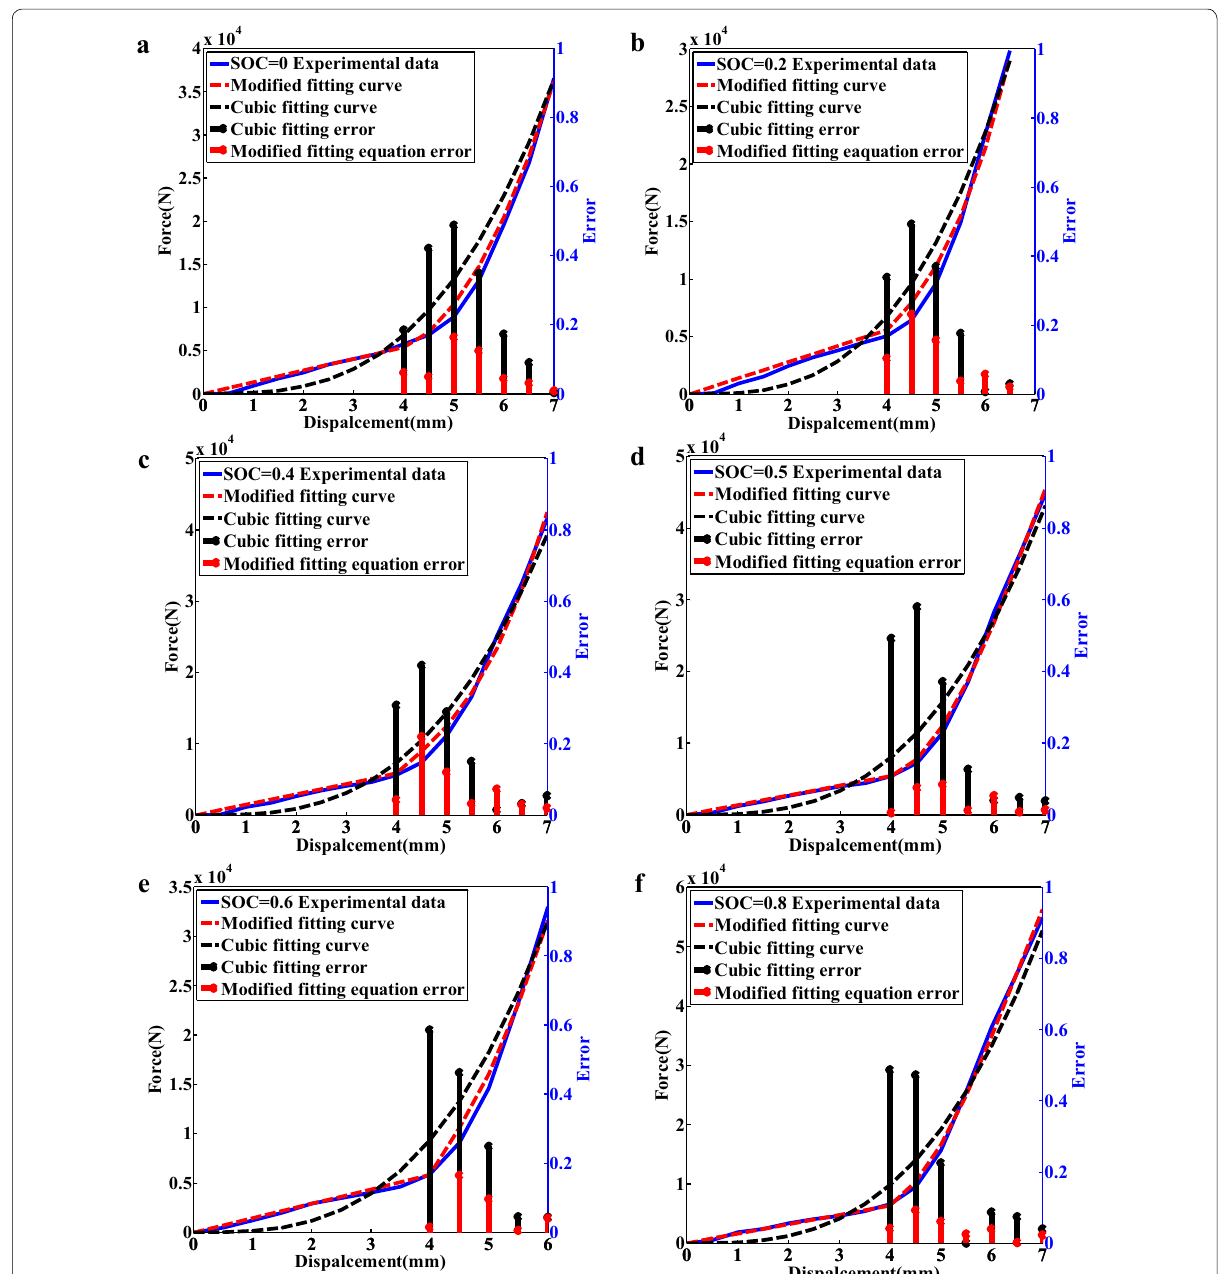
Figure 6 Comparison of equivalent mechanical model with cubic fitting equation under multi-SOC states. Comparison results of flat plate test under a SOC 0, b SOC 0.2, c SOC 0.4, d SOC 0.5, e SOC 0.6, and f SOC 0.8 = = = = = =